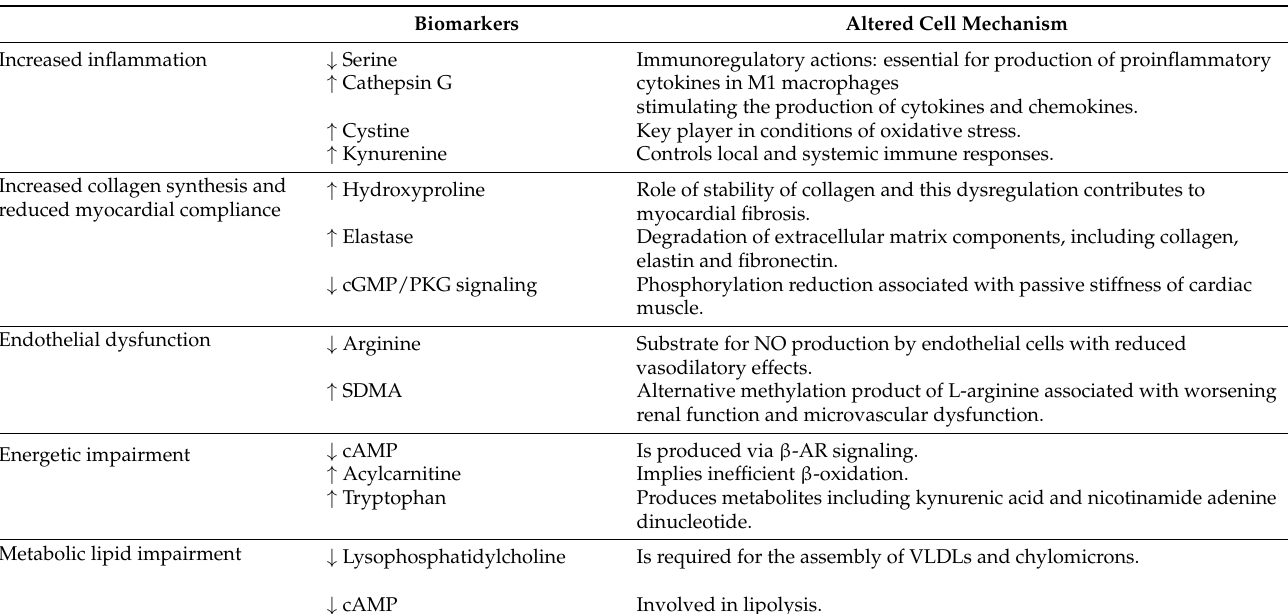
Table 2. Most common metabolomic pathways analyzed in HFpEF; different mechanisms sug- gest metabolic and energetic substrate alterations involving several cells including myocytes, macrophages, fibroblasts and